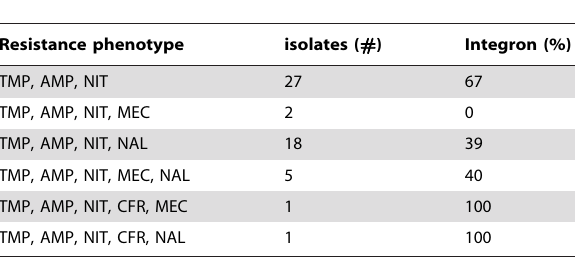
Table 4. The relationship between dfr- genes and integron class I and II in E. coli (n =320) and K. pneumoniae (n= 54). E.coli